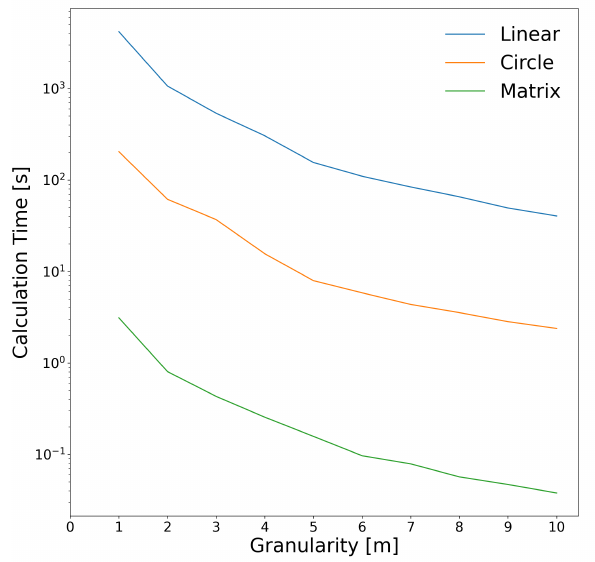
Figure 12. Calculation time according to their